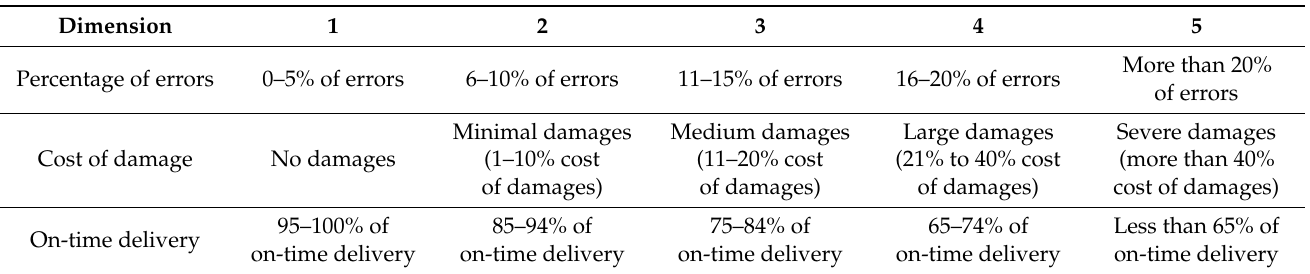
Table 1. Assessment scale for service quality dimensions.